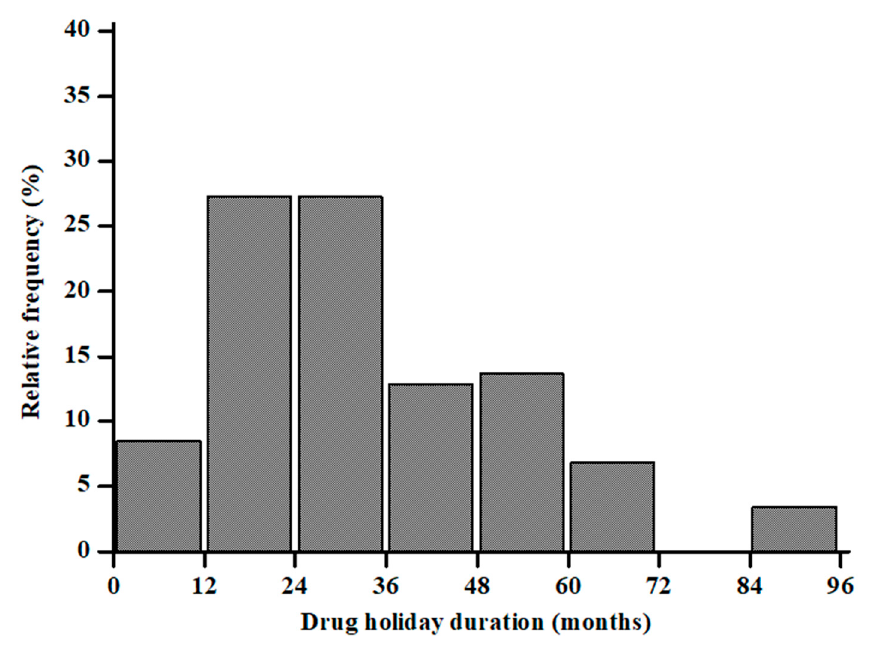
Figure 1. Distribution of months under treatment with ALN in a cohort of postmenopausal women. The length of discontinuation was inversely associated with time since menopause (r = − 0.32; p = 0.0005) and with loss of BMD at lumbar spine (r = − 0.27; p = 0.005) (Figure 2). BMD at the lumbar spine (0.70 ± 0.32 vs. 0.86 ± 0.11 g/cm 2 , p < 0.0001) and femoral neck (0.53 ± 0.28 vs. 0.63 ± 0.19 g/cm 2 , p < 0.001) increased significantly over the observation period in the entire cohort. BMD at lumbar spine increased significantly within each tertile ( p all < 0.05); on the other hand, BMD at femoral neck increased only in ∆ D3 tertile (0.45 ± 0.31 vs. 0.63 ± 0.16 g/cm 2 , p = 0.002) and remained not significantly changed in tertile ∆ D1 and ∆ D2 tertile ( p all > 0.05). S-25(OH)D at baseline was not associated with the BMD change neither at lumbar spine (r = 0.03, p = 0.08) nor femoral neck (r = 0.001, p = 0.7) after ALN discontinuation. The modification of s − 25(OH)D levels over time was inversely associated with the change of ALP (r = − 0.22, p = 0.018) and s-CTX levels (r = − 0.3, p = 0.06). Moreover, the participants in the ∆ D3, the one with the largest increase in s-25(OH)D levels, showed a 5.7% BMD gain, that was twice as great in comparison with participants with the lower 25(OH)D variation in ∆ D1 (Figure 3). At a multiple regression analysis, after correcting for ALN treatment duration, bone turnover marker modifications, BMI and age at menopause, the BMD change at lumbar spine was significantly associated with time since menopause (ß = 2.28, SE 0.44, p < 0.0001), FRAX score for major fracture (ß = − 0.65, SE 0.29, p = 0.03), ALN discontinuation duration (ß = − 2.17, SE 0.27, p < 0.0001) and change of s-25(OH)D levels (ß = 0.15, SE 0.03, p = 0.0007).